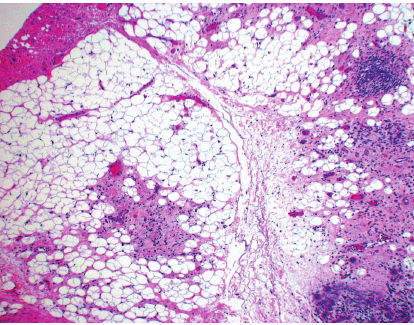
Figure 1: No-amifostine group (HE, Original magnification × 4.8). Near total fatty replacement of salivary lobules with focally intense lymphocytic inflammation can be observed. Note the e ff acement of general lobular architecture.